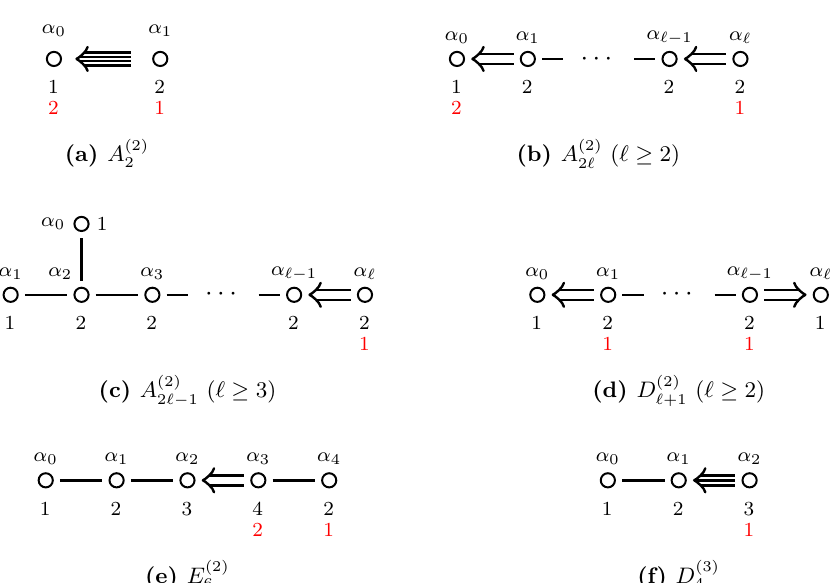
. The number assigned each ‘ . If a Coxeter label (mark) d i is different from d ∨ , it is i i